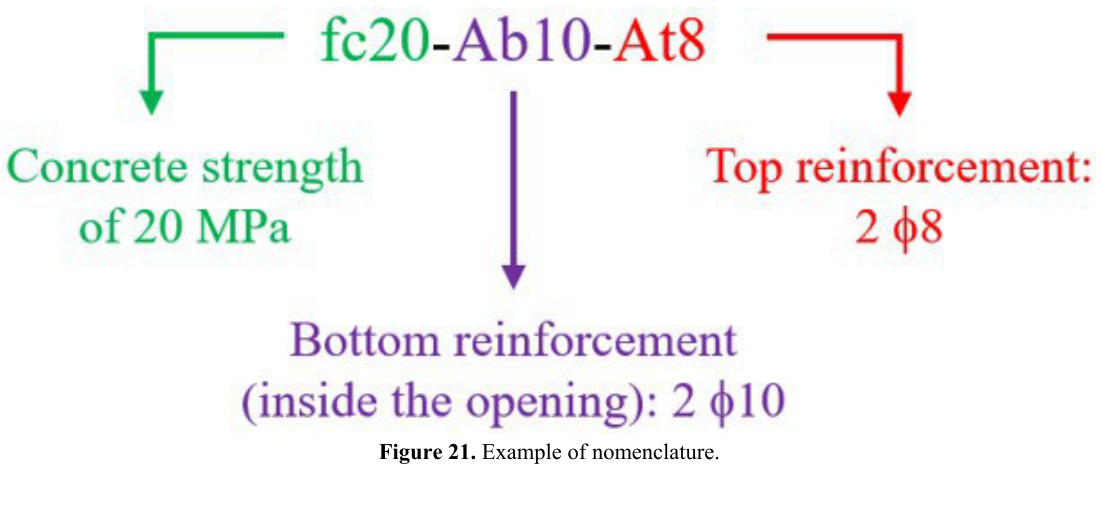
Figure 21. Example of